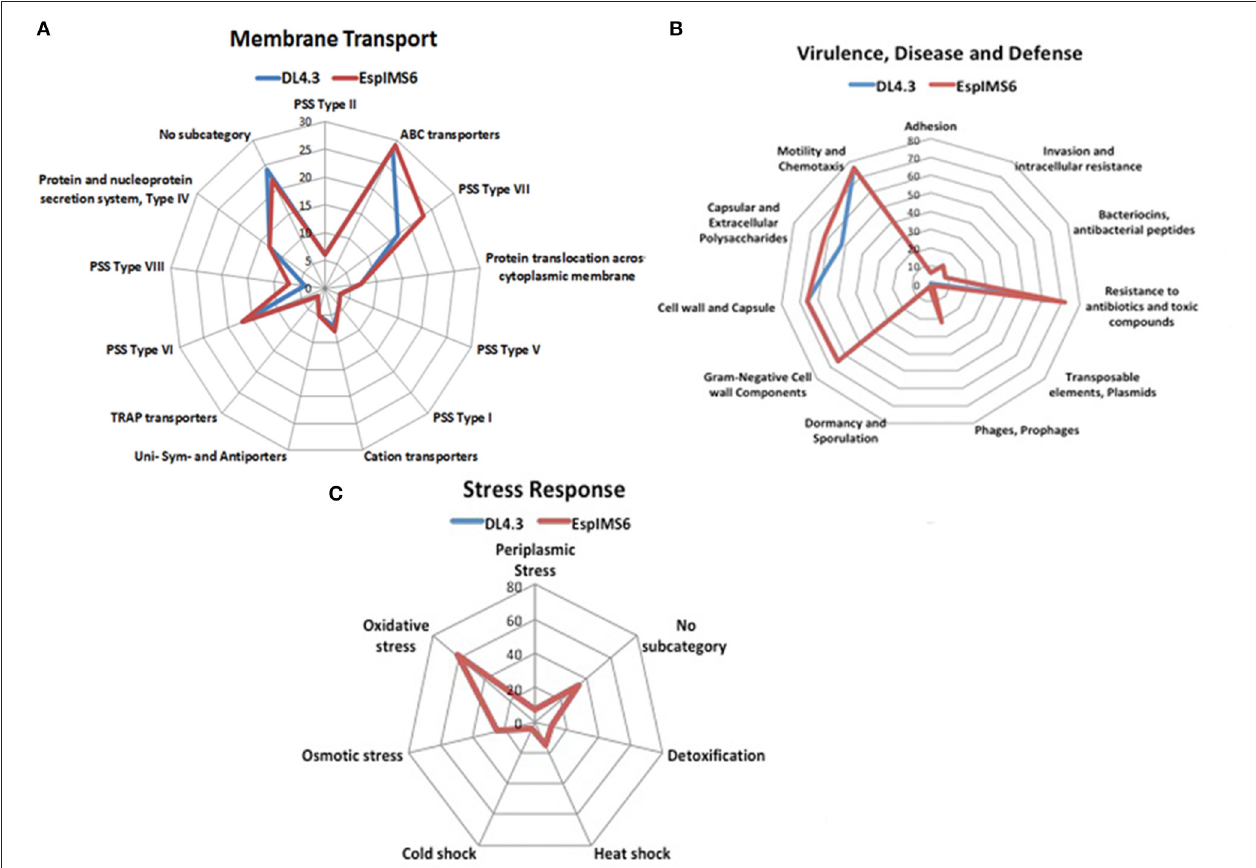
FIGURE 6 | Genetic makeup of environmental (DL4.3) and clinical (EspIMS6) Enterobacter isolates. Spider plots generated using the number of genes involved in each function revealed critical genomic differences and similarities between wild type environmental DL4.3 and clinical EspIMS6 isolate in different categories like (A) membrane transport, (B) virulence, disease and defense, and (C) stress